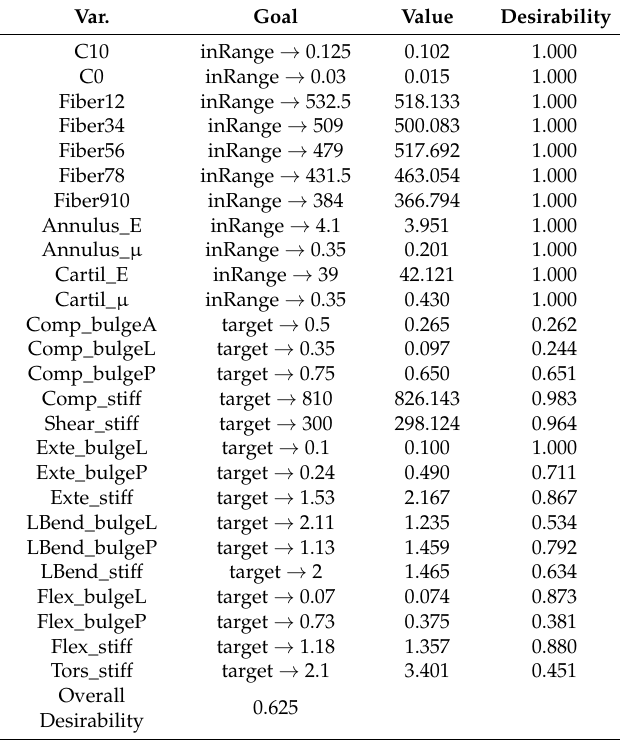
Table 28. The first criterion considered inputs and outputs that were considered equally important.